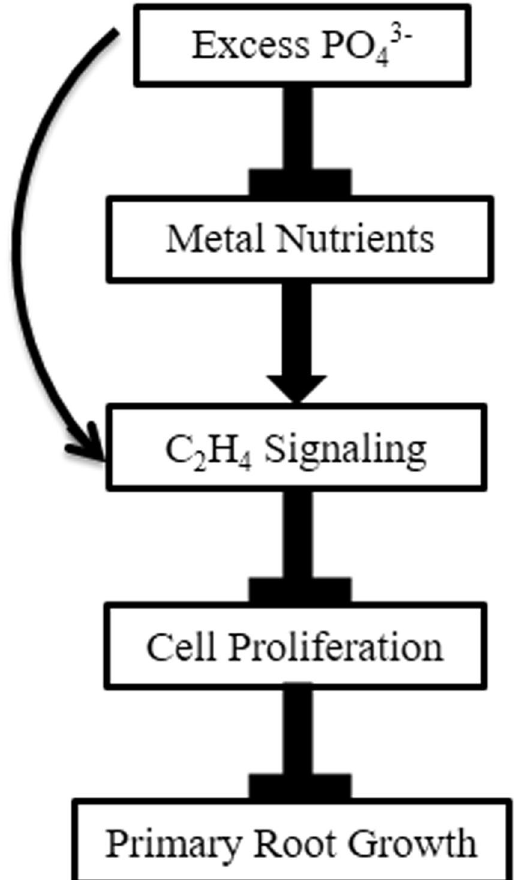
Figure 10. A common minimum consensus model displaying underlying signaling occurred during Excess Phosphate Response (EP i R). Excess phosphate treatment triggers the ethylene response may be directly or by altering nutrient profile and negatively regulates primary root growth by reducing cell proliferation in root apical